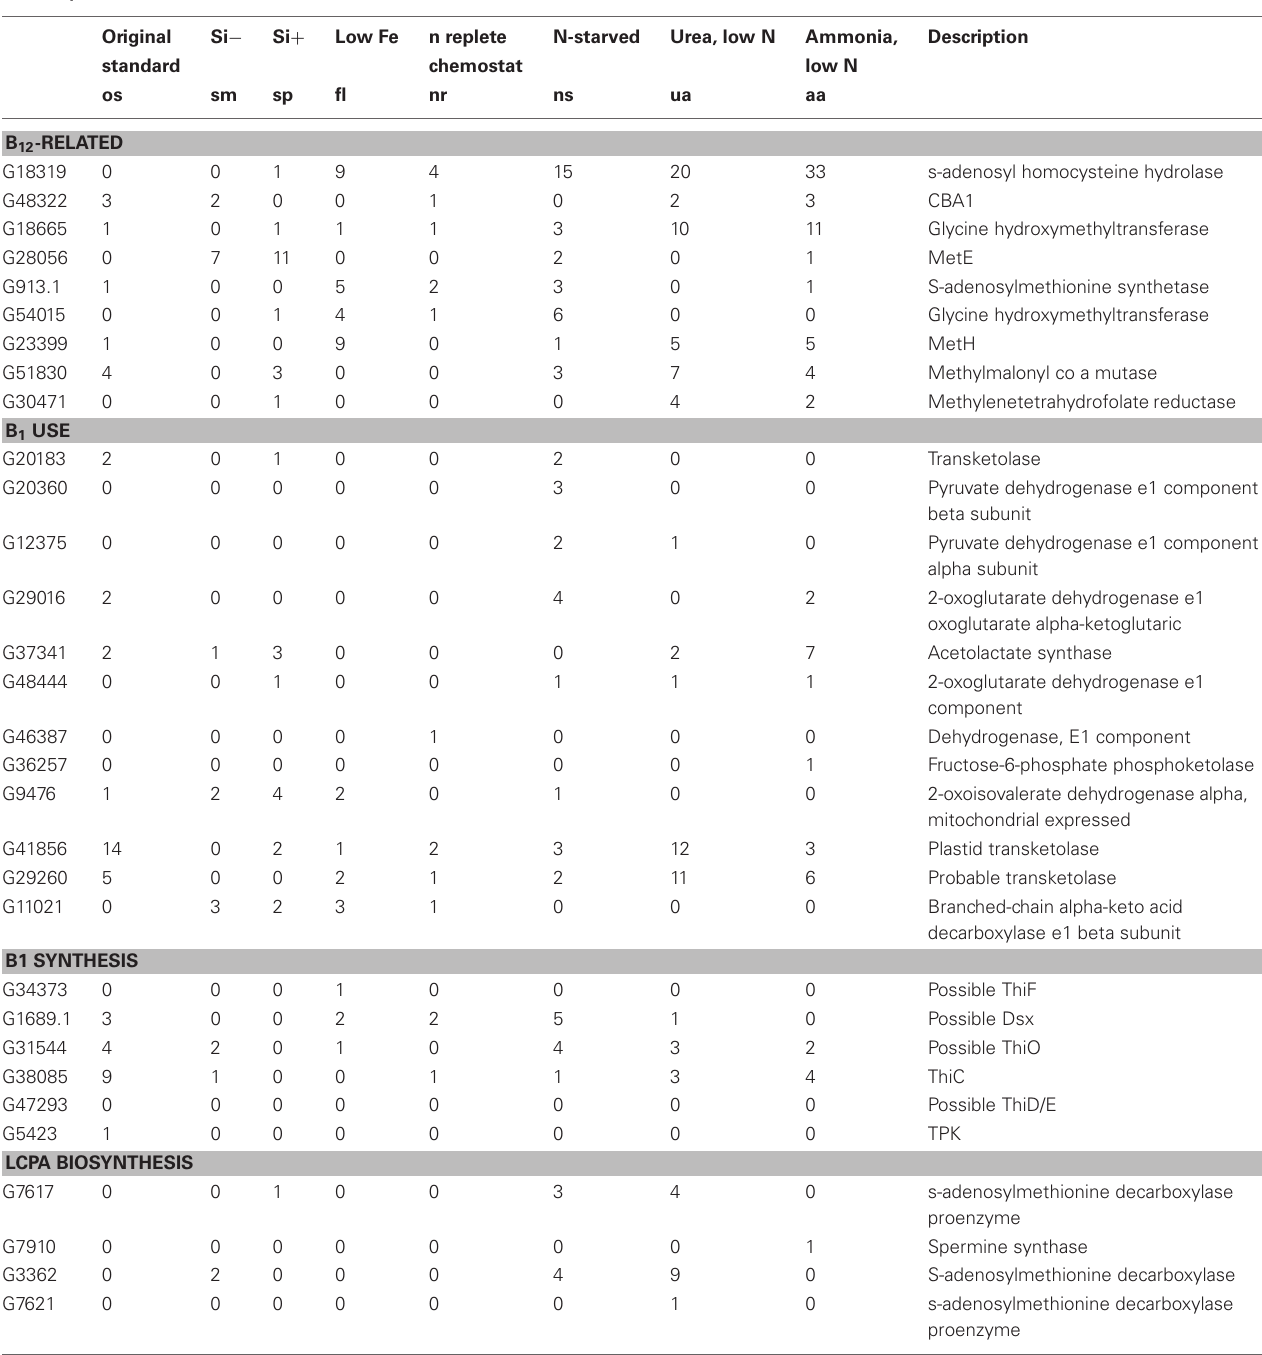
Table 4 | B 12 and B 1 related genes from published P. tricornutum EST